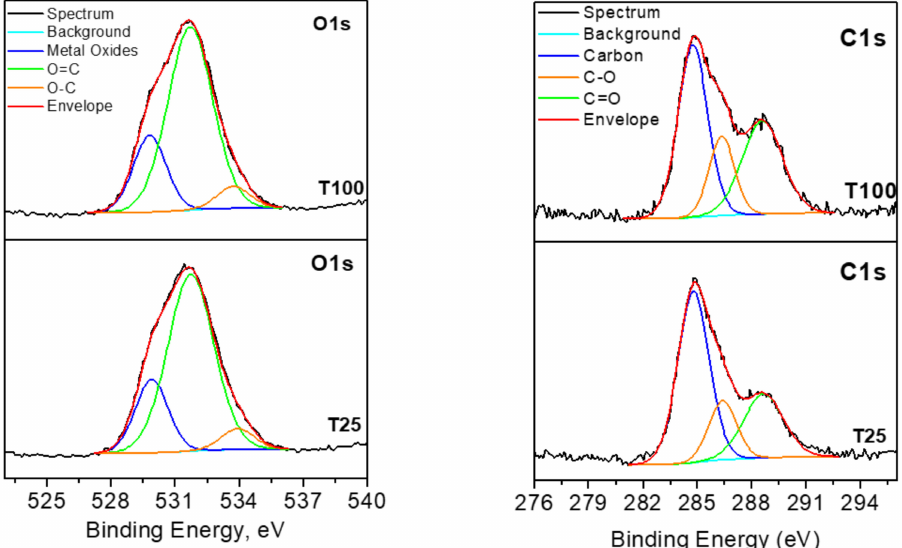
Figure 3. Deconvolution of O1s spectra ( left ) and C1s spectra ( right ) of chitosan-ZrO 2 multilayers. Table 2. XPS results of the deconvoluted components of C1s peak. Binding Energy (eV)